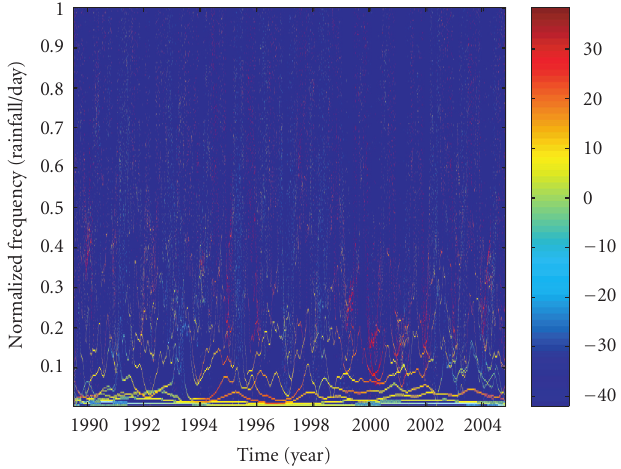
Figure 3.2. Hilbert amplitude spectrum (or simply Hilbert spectrum) of the decomposed rainfall data using 256 frequency bins. The amplitude is in